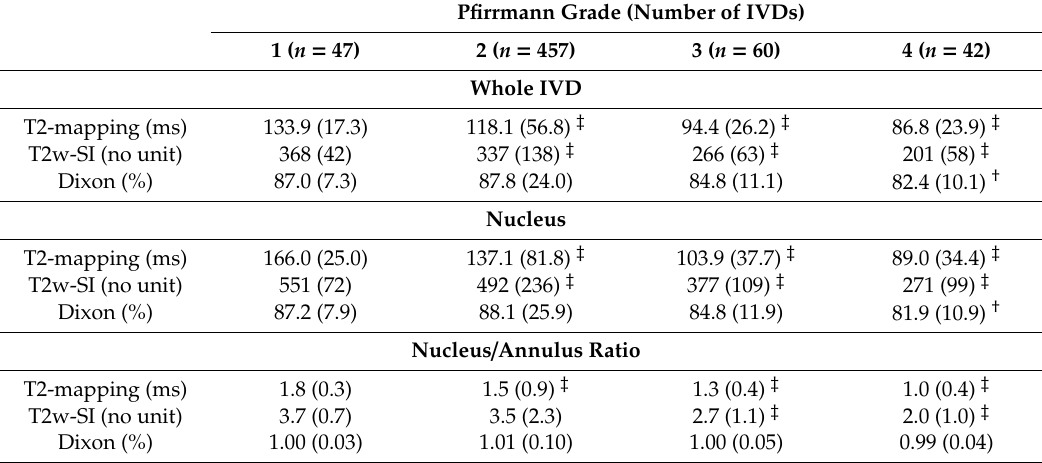
Table 2. T2-mapping and T2w imaging reflected the IVD Pfirrmann grades, but Dixon imaging was less sensitive.